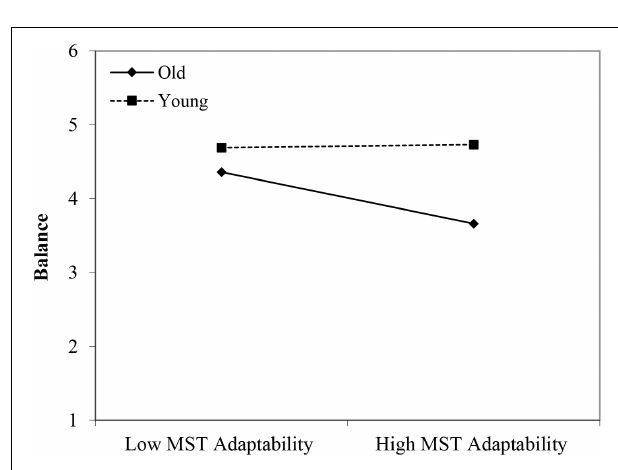
FIGURE 12 | Interaction between perceived age-based (meta-)stereotyping adaptability and age groups: Predicting balance. Low = –1 SD , High = + 1 SD , MST = perceived age-based (meta-)stereotyping adaptability, old = older workers, young = younger workers.